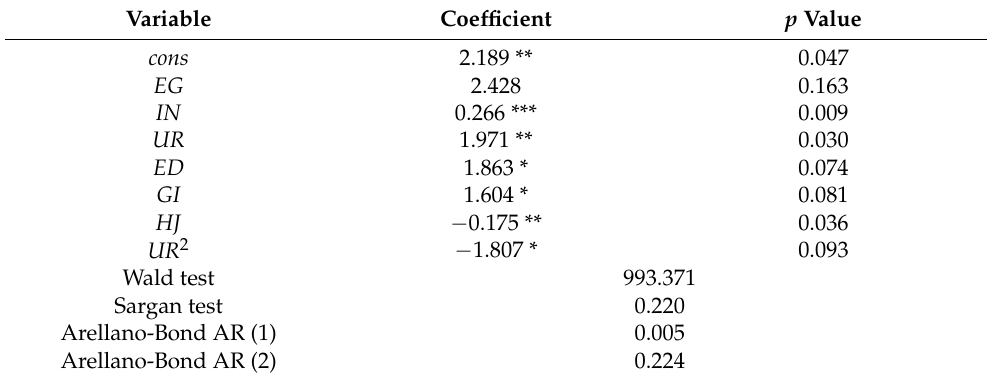
Table 10. Results of robustness test